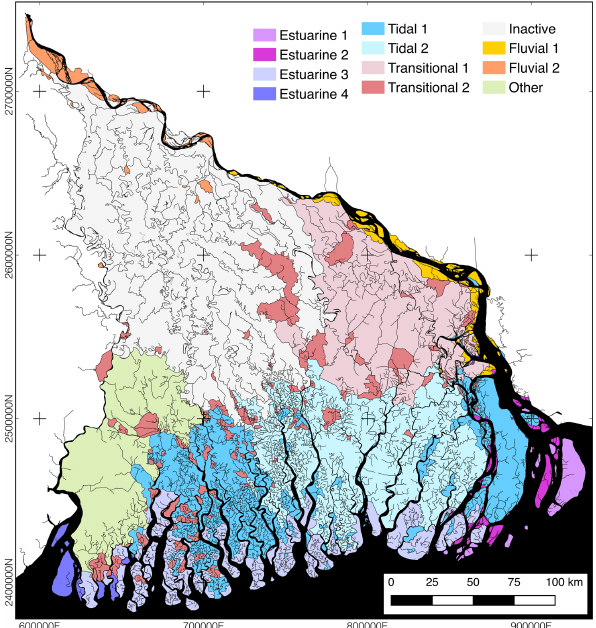
Figure 5. Island classification as a result of the hierarchical ag- glomerative clustering method using a geographic constraint so that only adjacent islands can be grouped. Each island in the GBMD is classified into 12 individual clusters. The 12 individual clusters are further grouped into six main classes using a dendrogram (Fig. 6).